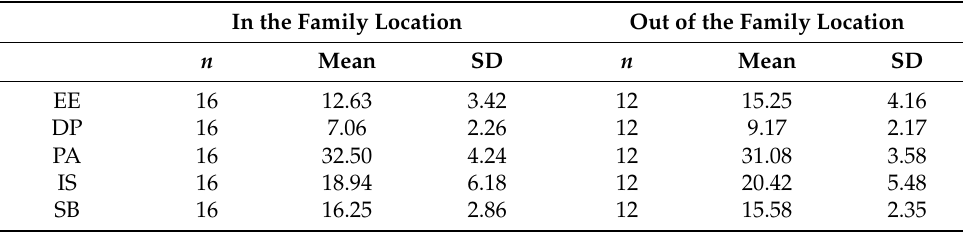
Table 8. Results of the dimensions by teaching location.